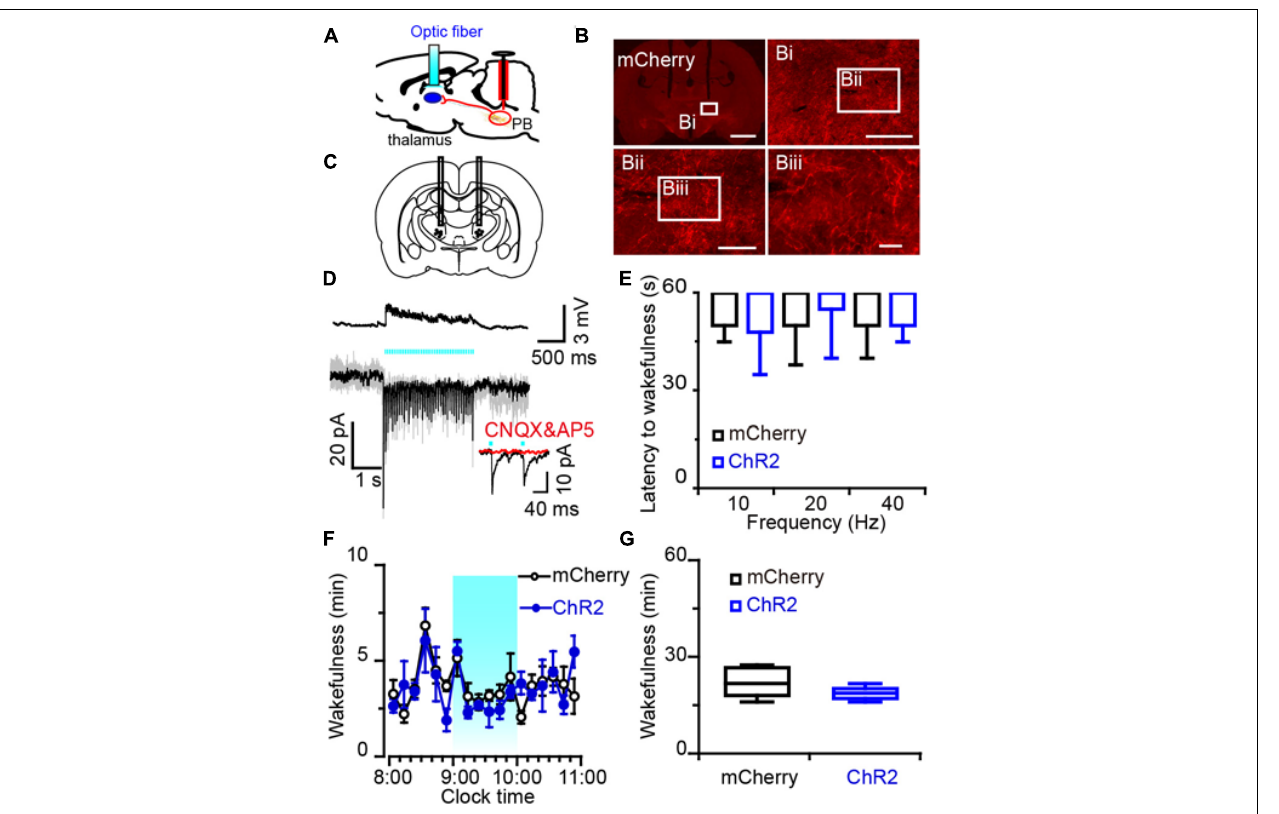
FIGURE 6 | Photostimulation of MPB axonal terminals in the VM had no effect on wake response in rats. (A) Diagram depicting the location of the optic fiber in the VM of a rat injected with AAV-CaMKII α -ChR2-mCherry or AAV-CaMKII α -mCherry in the MPB. (B) Coronal sections with native mCherry fluorescence confirmed the expression of ChR2 protein in the VM. Scale bars: b = 2 mm; bi = 500 µ m; bii = 200 µ m; biii = 50 µ m. (C) The schematic diagram showing the cannula traces and the optic fibers targeting the VM. (D) Optogenetic stimulation of MPB axons increased firing frequency and evoked synchronized EPSCs in VM neurons. Evoked EPSCs were blocked by CNQX and AP5 (red trains). (E) Latency of sleep to wakefulness after photostimulation in the frequency range of 10–40 Hz. (F,G) The time course (F) and total amount (G) of wakefulness during optogenetic stimulation in the LH, compared with mCherry groups ( n =